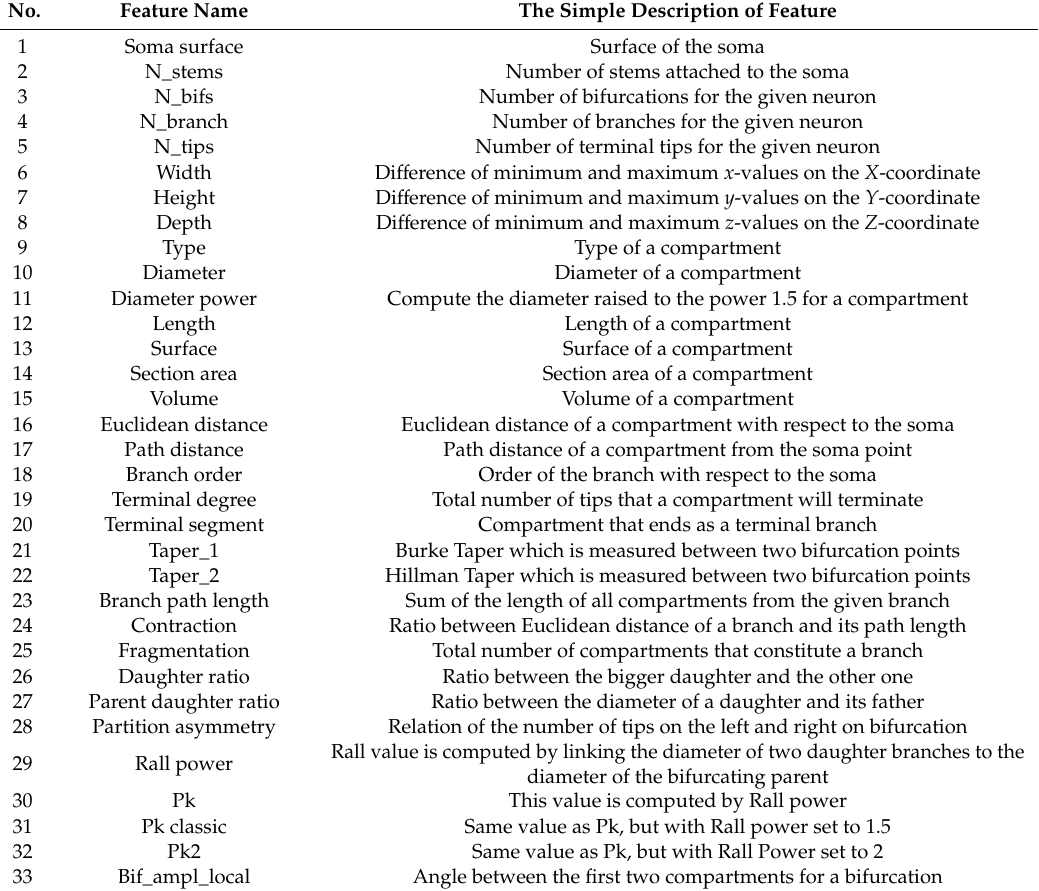
Table 1. Neuronal morphological features extracted by